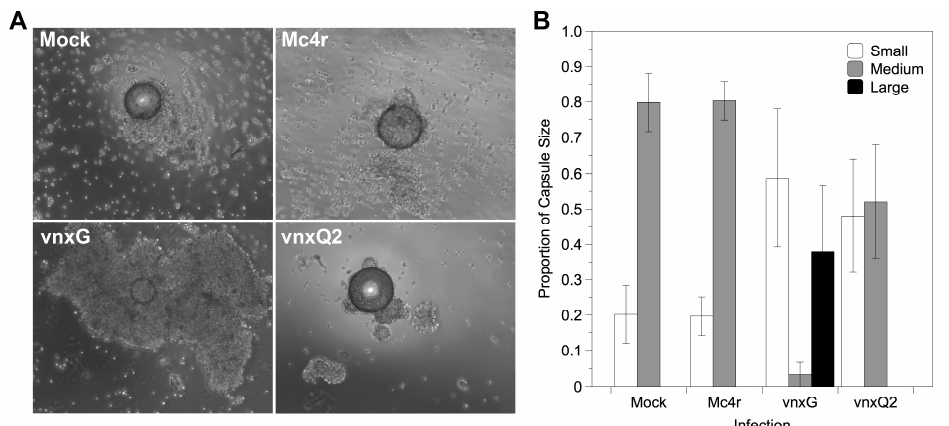
Figure 6. Vinnexin expression disturbs hemocyte encapsulation function. Isolated hemocytes cultured with chromatography beads were imaged for formation of cellular capsules. ( A ) Representative micrographs of encapsulation results for each treatment. ( B ) Proportion of encapsulation shown by hemocytes of each treatment according to a 1–3 scale (see text); bars and variance represent mean and s.e.m.,